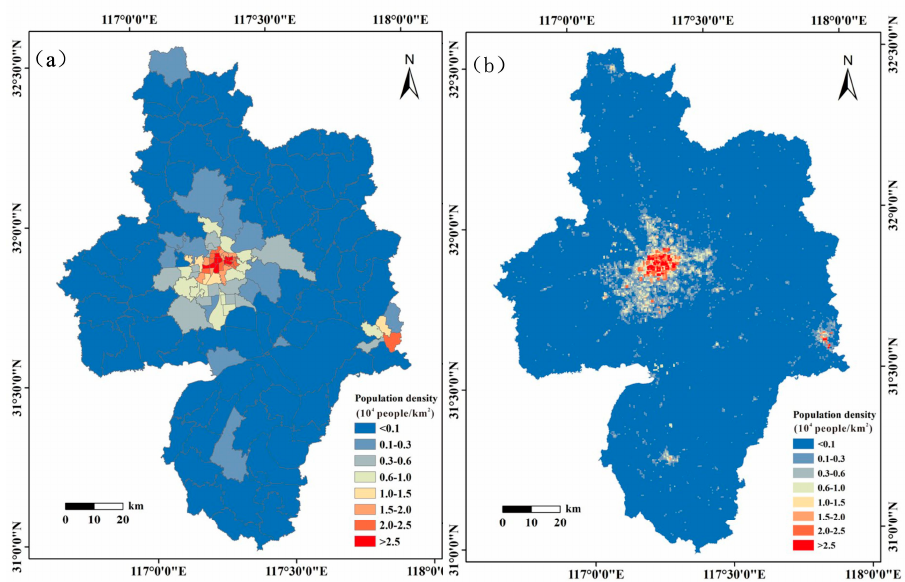
Figure 7. ( a ) Population density (10 4 people/km 2 ) distribution of Hefei at the township scale; ( b ) Spatial distribution of the population density (10 4 people/km 2 ) at the 500 m pixel scale.